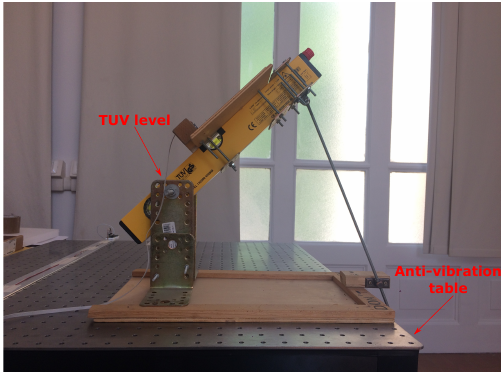
Figure 6. Experimental setup in pseudo-static conditions: anti-vibration table equipped with TUV level.